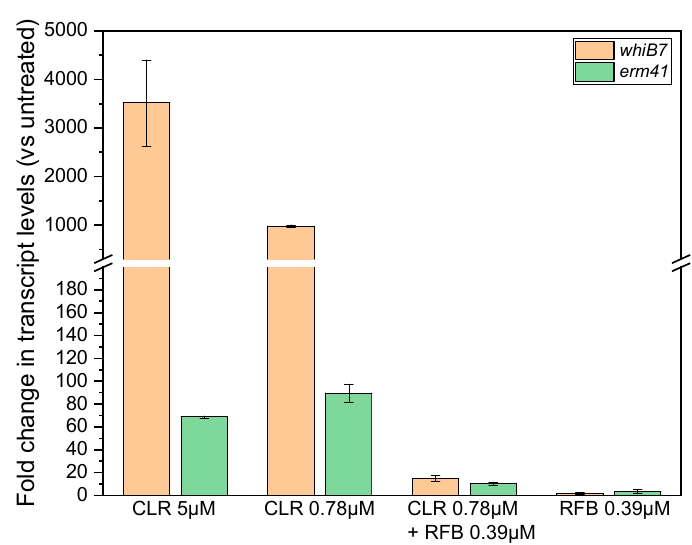
Figure 1. Effect of treatment of M. abscessus with clarithromycin and/or rifabutin on whiB7 and erm41 mRNA levels. M. abscessus ATCC19977 cultures were exposed for 30 min to clarithromycin (CLR), rifabutin (RFB) or a combination of both antibiotics and relative transcript levels were determined. Fold changes compared to untreated cultures are shown. CLR 5 µM: MIC of CLR. CLR 0.78 µM: subinhibitory CLR concentration used in the synergistic combination. CLR 0.78 µM + RFB 0.39 µM: synergistic, growth inhibitory combination. RFB 0.39 µM: subinhibitory RFB concentration used in the synergistic combination. Transcript levels were measured by qRT-PCR and normalized to rpsA as described [6]. Shown are mean values with standard deviations from two independent experiments. 0.78 µM CLR corresponds to 1 mg/L; 0.39 µM RFB corresponds to 0.46 mg/L.